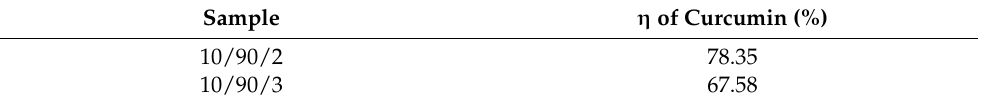
Table 4. The efficiency of curcumin incorporation ( η ) into p(NiPMAm/NiPAm)